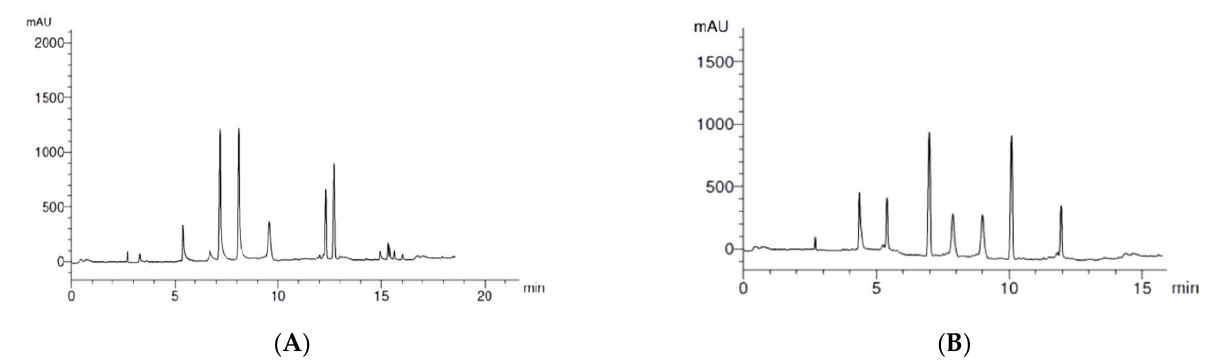
Figure 1. HPLC chromatograms of Alchemilla vulgaris root extract: ( A ) phenol components; ( B ) fla- vonoid components. Table 3. Concentrations of flavonoid components of Alchemilla vulgaris root extract by